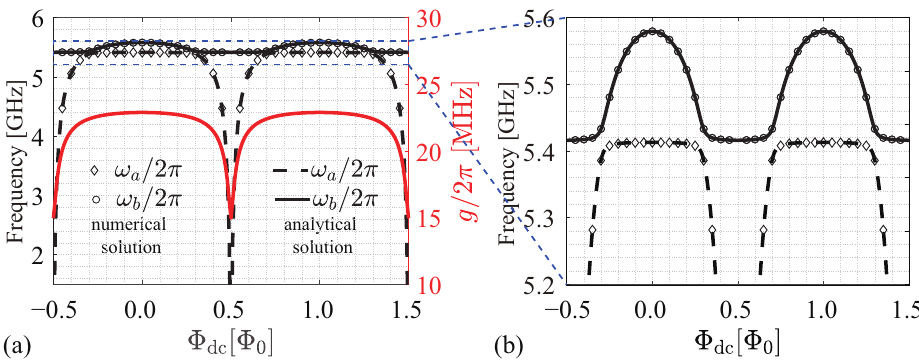
Figure 2. ( a ) Spectroscopy of the circuit as a function of the dc flux bias Φ dc . The dashed (solid) black line (left axis) represents the resonant frequency ω a /2 π ( ω b /2 π ) of the mode a ( b ) with analytical solutions using Equation (2). The data marked by diamonds and circles are the numerical solutions according to Equation (1). The red line (right axis) is the effective coupling strength g /2 π . ( b ) The enlarged view of the blue dashed box in (a) explicitly displays the anti-crossings between the two